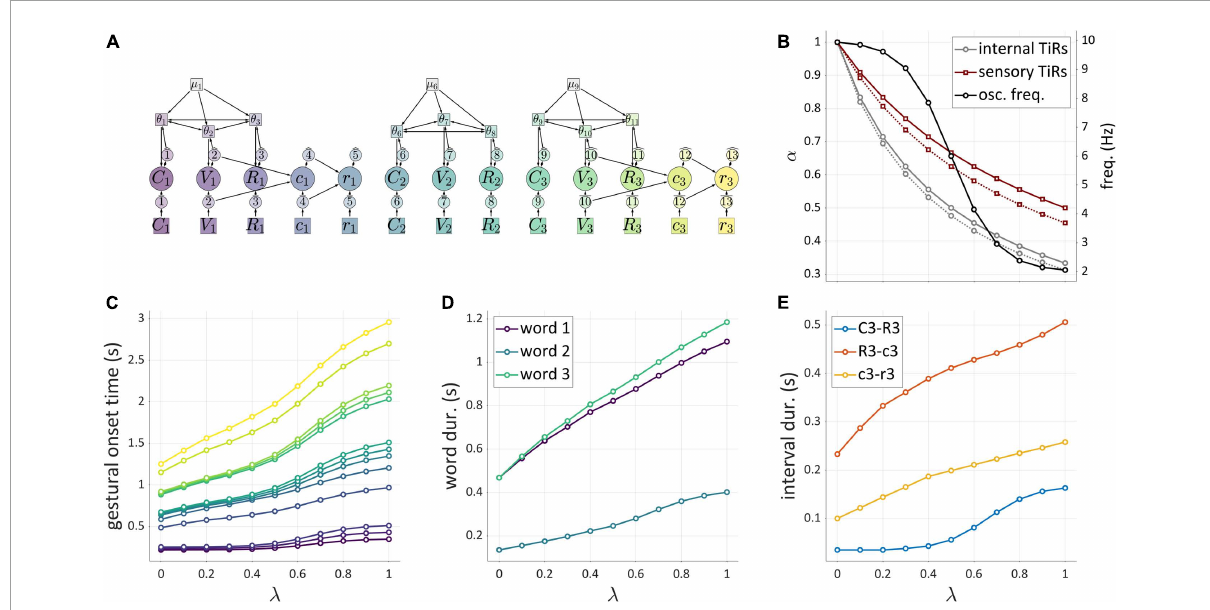
FIGURE13 Simulation of variation in speech rate, as controlled by correlated chagnes in self-attention and pacing, both indexed by λ . (A) Model schema showing three syllables with the forms CVC, CV, and CVC. (B) Relations between λ and feedback TiR integration rates ( α ) and oscillator frequencies. (C) Times of gestural initiation for each value of λ simulated. (D,E) Word durations and interval durations of the third